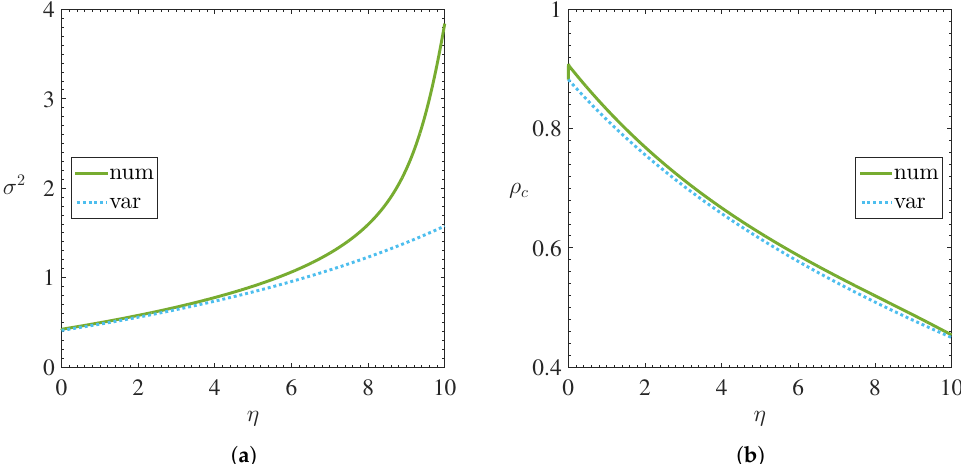
Figure 2. Numerical and variational results illustrating the behavior of ( a ) mean square width σ 2 and ( b ) central density ρ c as a function of the nonlinearity coefficient η . Solid lines represent numerical solutions while dotted lines represent variational